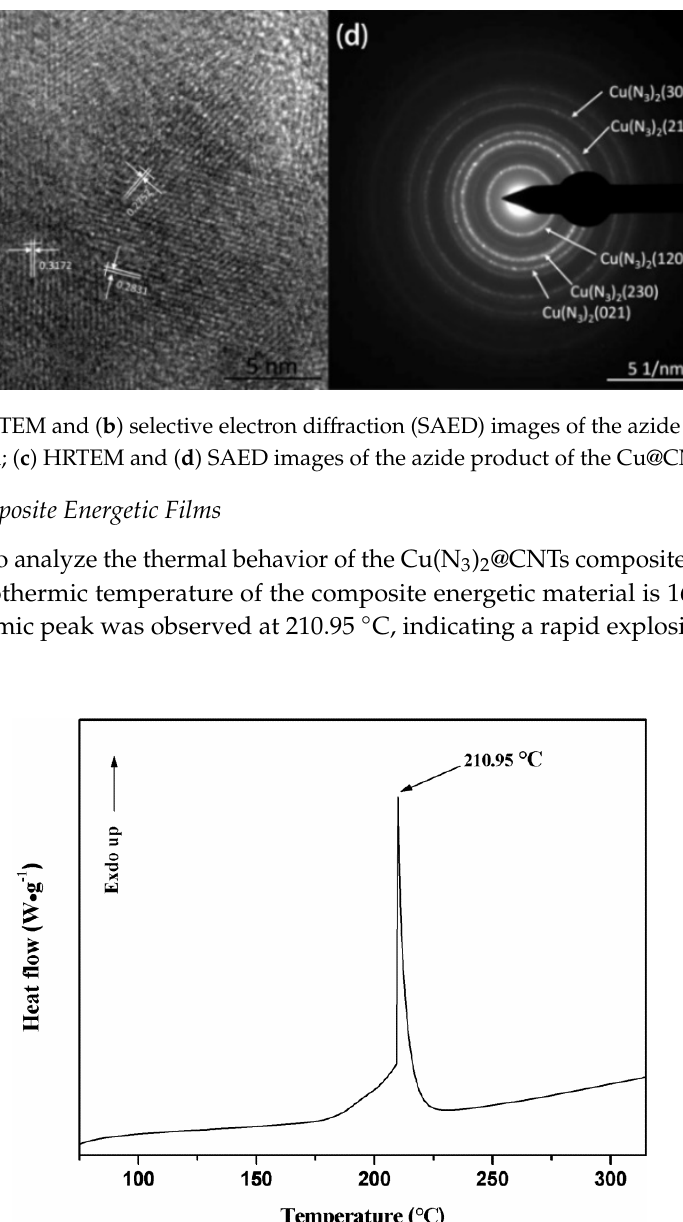
Figure 14. Differential scanning calorimetry (DSC) result of the copper azide filled CNTs energetic film .